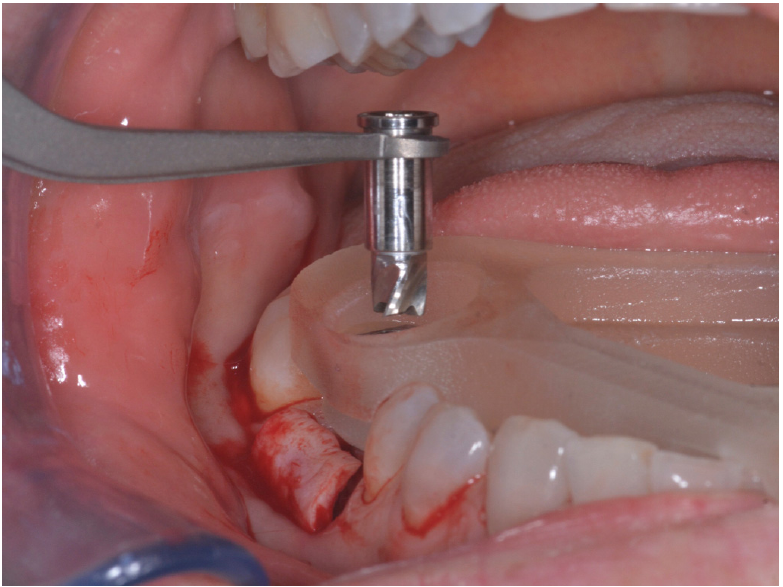
Figure 6. Intraoperative view of the guided cortical drill, held with dedicated tweezers before the insertion into the sleeve.